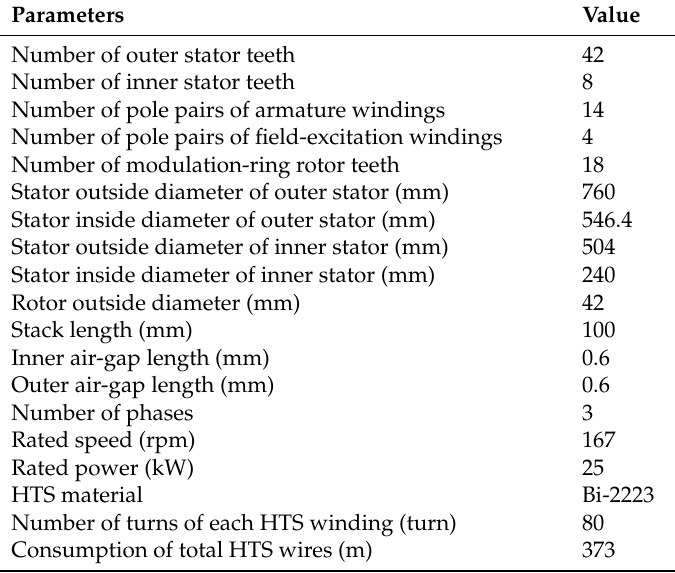
Table 2. Key parameters of the proposed machine.